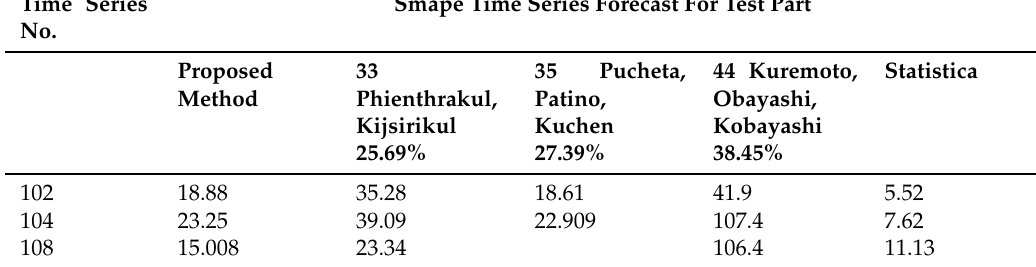
Table 9. Methods comparison.